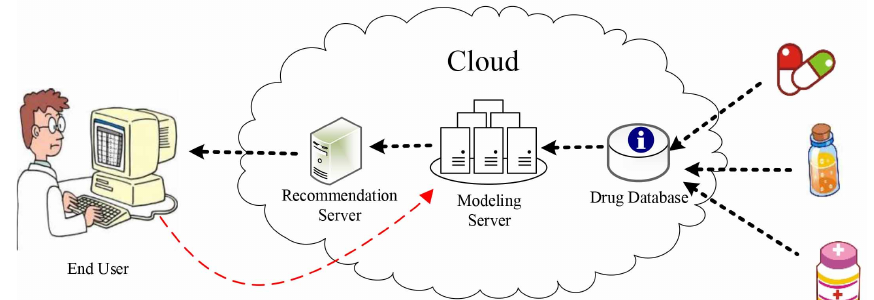
Fig. 1. Architecture of COMER